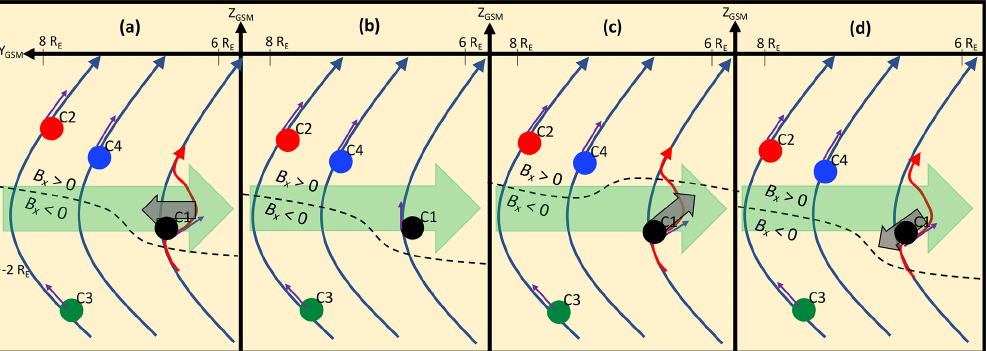
Figure 7. Schematic diagrams of the observed magnetic field perturbations and dusk–dawn convective flows during the time windows indicated in Fig. 6 by the highlighted regions. The approximate locations of the four Cluster spacecraft relative to one another in the Y – Z GSM plane are indicated (not to scale) by the coloured circles. The curved blue arrows represent magnetic field lines, and the short purple arrow indicates the local sense of B y at the location of each spacecraft. The dashed black line indicates the current sheet. In panels (a) , (c) and (d) , the curved red arrow shows the “kinked” magnetic field line. The long thick green arrow shows the direction of the model ( J × B ) y force associated with the background curvature of the magnetic field, and the small thick grey arrow shows the direction of the dusk–dawn convective flow observed by